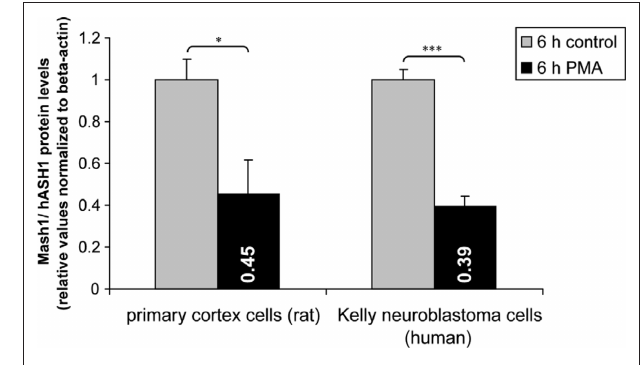
Figure A1 | Phorbol 12-myristate 13-acetate dose dependent suppression mediated by hASH1 mrNA uTrs. Kelly neuroblastoma cells were transiently transfected with reporter gene constructs in which the luciferase mRNA UTRs were replaced by the hASH1 5 ′ - and 3 ′ UTRs. Luciferase activity was measured following 24 h PMA administration. n = 12; ** p < 0.01, ** p < 0.001.